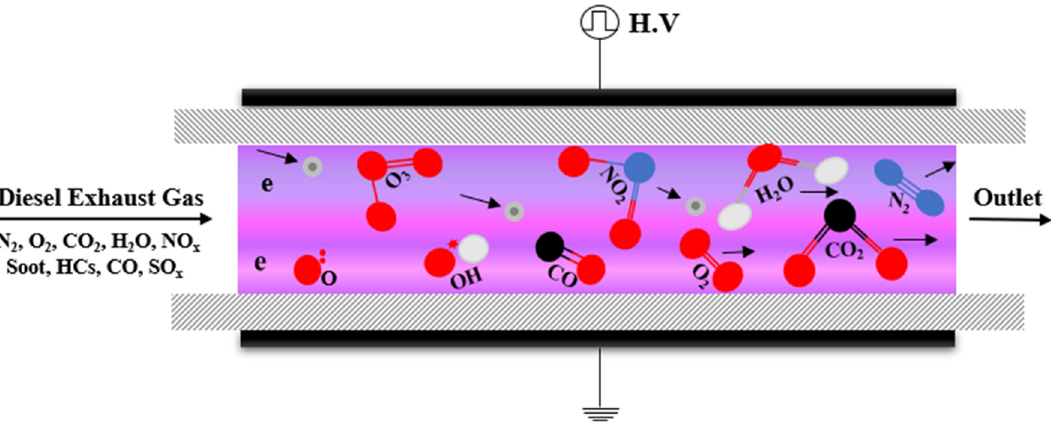
Figure 6. Mechanism atmospheric pressure plasma for Diesel particulate matter treatment.